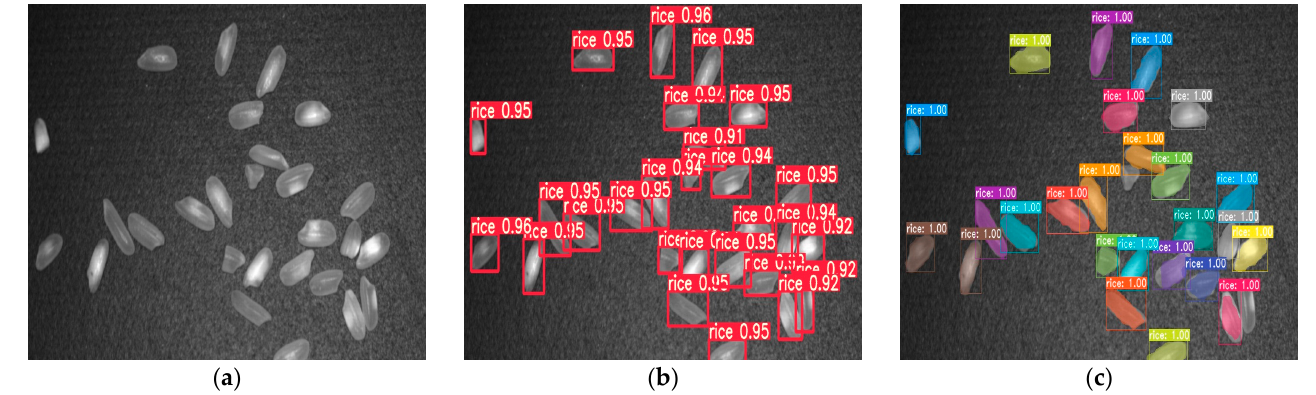
Figure 7. Comparison of direct prediction results of different networks on the whole polished rice map: ( a ) original graph; ( b ) YOLOv5 network prediction; ( c ) YOLACT network prediction.